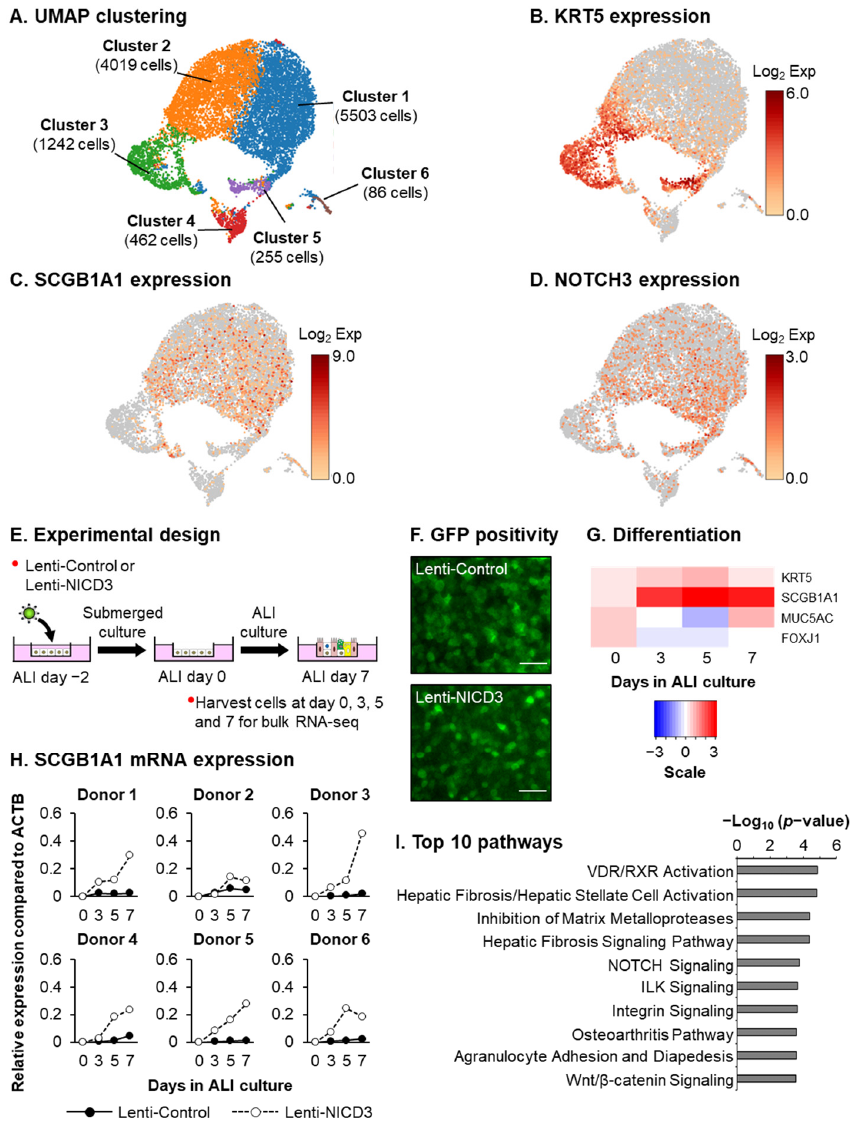
Figure 1. Activation of NOTCH3 signaling promotes club cell differentiation. ( A – D ) scRNA-seq analysis of HBECs cultured on ALI for 9 days. ( A ) UMAP clustering using K-means 6 clustering approach of 11,567 cells from a single HBEC donor. ( B ) Expression of KRT5 (basal cell marker). ( C ) Expression of SCGB1A1 (club cell marker). ( D ) Expression of NOTCH3. ( E ) Experimental design. HBECs ( n = 6 normal, nonsmoker donors) were infected on air–liquid interface (ALI) with either control lentivirus (Lenti-Control) or lentivirus expressing the activated NOTCH3 NICD (Lenti- NICD3). The cells were then harvested as a function of time (ALI days 0, 3, 5 and 7) for subsequent analysis by qPCR and bulk RNA-seq. ( F ) GFP positivity of Lenti-Control and Lenti-NICD3 infected cells. Scale bar = 100 µ m. ( G ) Heatmap showing temporal expression of markers for basal (KRT5), club (SCGB1A1), goblet (MUC5AC) and ciliated (FOXJ1) cells in response to NICD3 expression by bulk RNA-seq. Scale bar represents log 2 fold change in expression in Lenti-NICD3 vs. Lenti-Control infected cells. ( H ) qPCR of SCGB1A1 (club cell marker) expression in Lenti-Control and Lenti-NICD3 infected cells from each HBEC donor. ( I ) Pathways enriched in the list of 692 NICD3-responsive genes identified by bulk RNA-seq on the basis of Ingenuity Pathway Analysis (IPA). Shown are the top 10 IPA-enriched pathways based on p -value (negative log 10